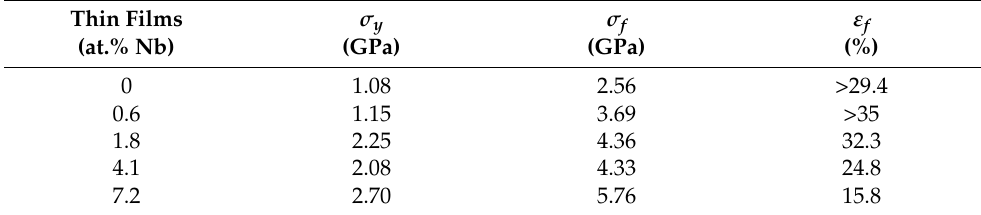
Figure 8. Engineering compressive stress–strain curves of micropillar compression tests of Nb x - CoCrFeMnNi HEAFs. Table 4. The compressive yield strength ( σ y ), fracture strength ( σ f ), and fracture strain ( ε f ) of Nb x -CoCrFeMnNi